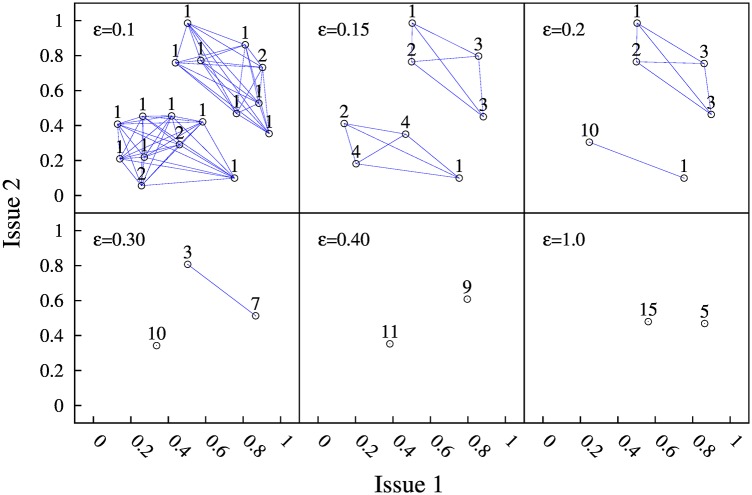
Six final absorbing states for a 20 agents system, starting from same initial condition (but different confidence levels ε, indicated at the upper-left corner of each panel).The initial opinions are shown in the upper-left panel of Fig 8. The random initial network has the same number of positive and negative links, and we take p = 0.3. The numbers in each panel indicate the number of agents with the same opinion (the number of agents in an opinion cluster). The grey lines show the positive links between agents. In the absorbing states there are neither negative links between agents in an opinion cluster nor negative links between agents in a clique. In the cases with ε = 0.4 and ε = 1, there is consensus of opinions in each clique.